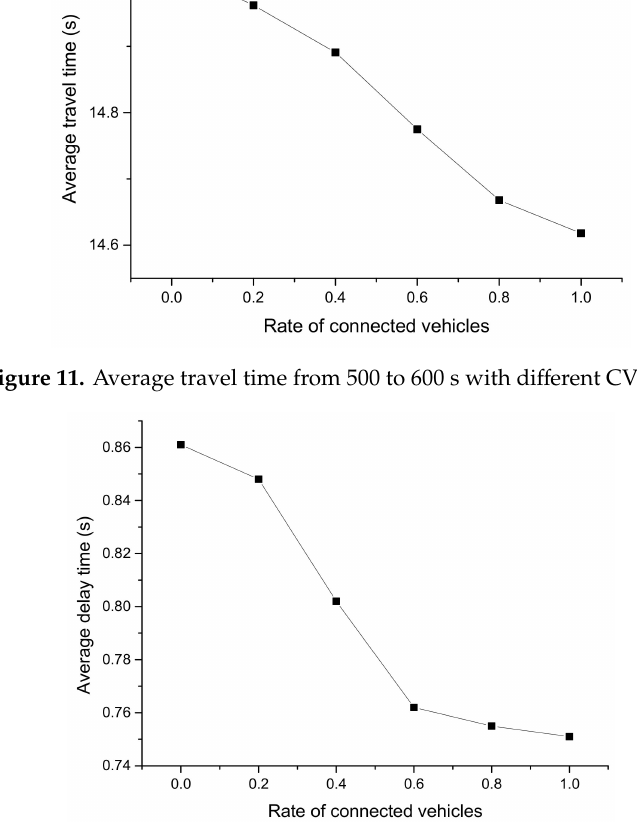
Figure 12. Average delay time from 500 to 600 s with di ff erent CV